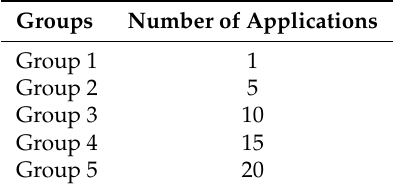
Table 6. Group of